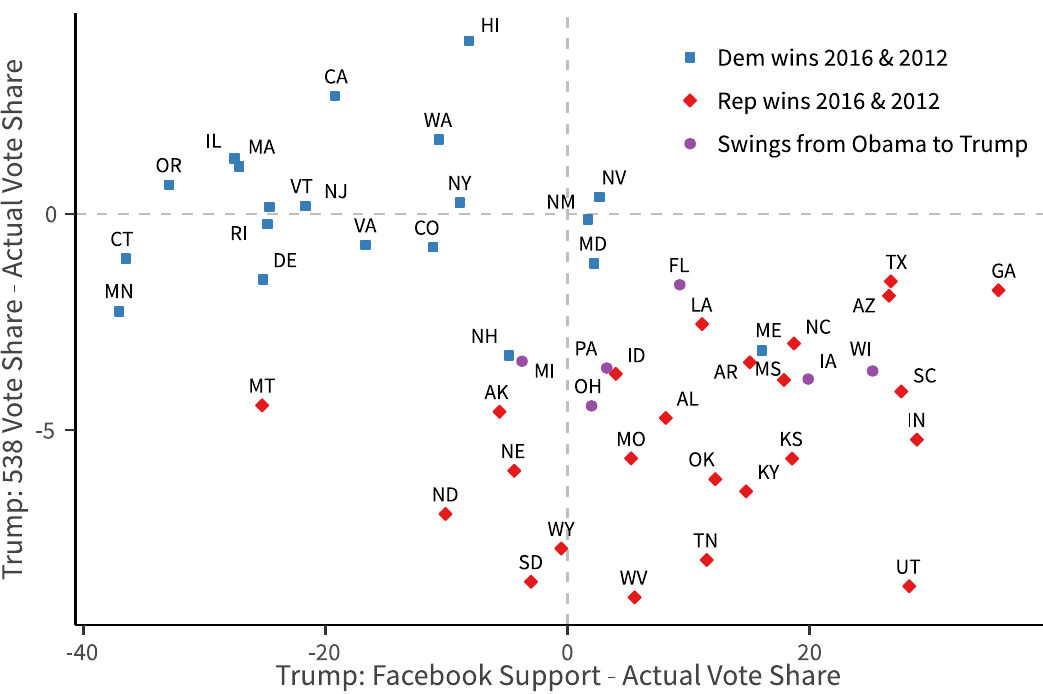
Fig 17. Compare Trump’s Facebook support rate and polling-based predicted vote share with actual vote share. Facebook support rate: Share of user’s ideology closer to Clinton, using data one month before the week of election (2016-10-09 to 2016-11- 05). 538 Polling Average: “Nowcast” for 2016-11-08 from